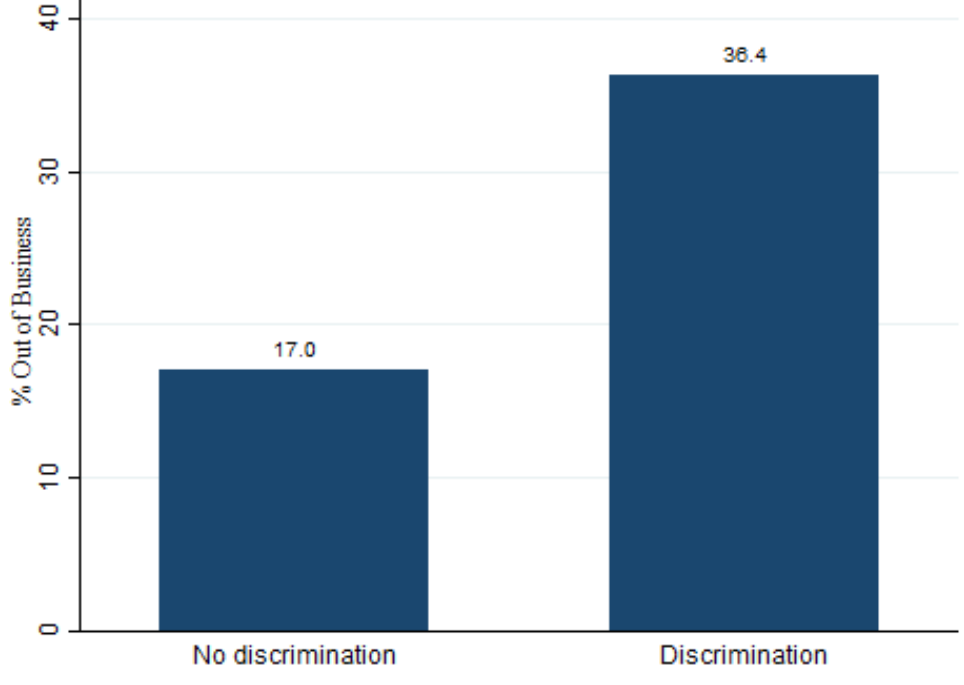
Figure 1: Percent of employers no longer in business in 2010 by evidence of discrimination in